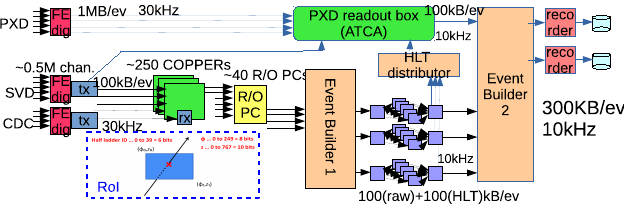
Figure 3. The RoI feedback to PXD readout. The track information obtained by HLT processing (Region of Interest: RoI) is fed back to the PXD readout box and only the hits associated to the tracks are